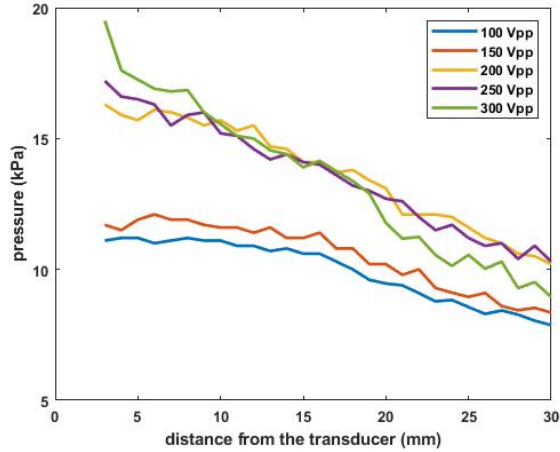
Figure 9. Acoustic pressure measurement results.